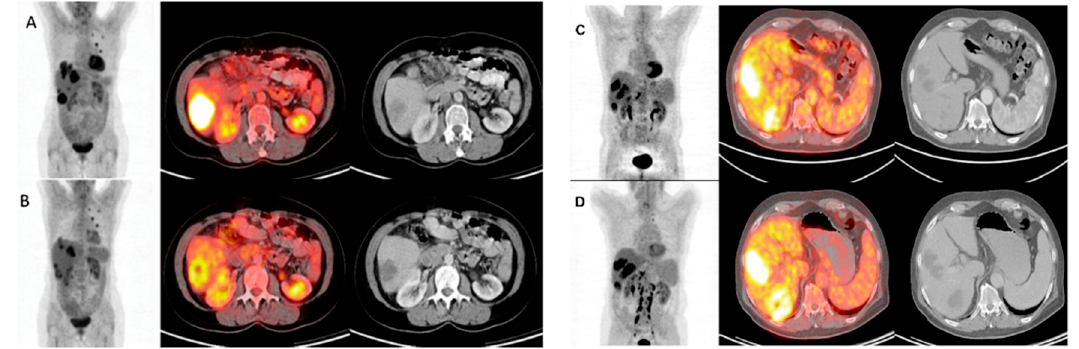
Figure 2. FDG ‐ PET/CT images before ( A and C ) and 4 weeks after ( B and D ) 90 Y ‐ microsphere radioembolisation in liver ‐ dominant mCRC; ( A and B ) The illustrated metabolic response was associated with a survival of 12 months after treatment; ( C and D ) This metabolic non ‐ responder survived 5 months after treatment. Figure reproduced with permission from Sabet et al. [35].